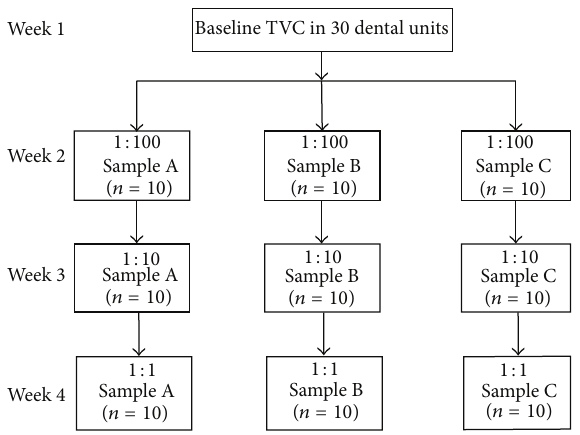
Figure 3: Standard plate count or total viable count